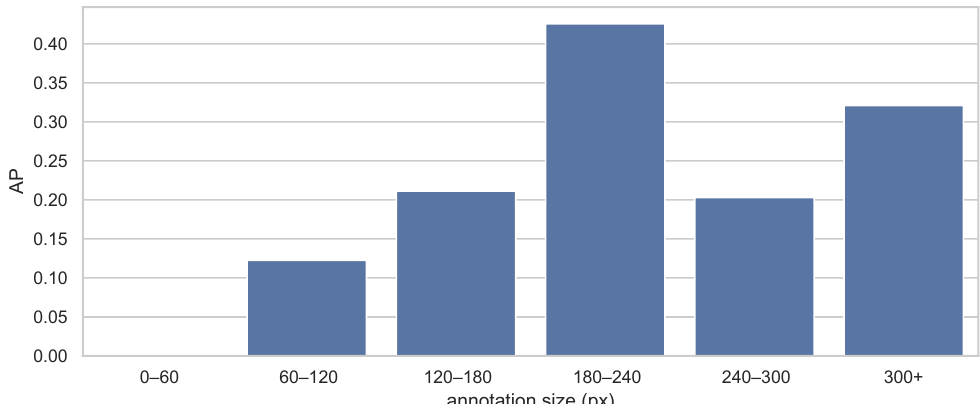
Figure 15. Influence of the distance from the sunflower (smaller flowers are assumed to be further away from the camera) on the detection accuracy.